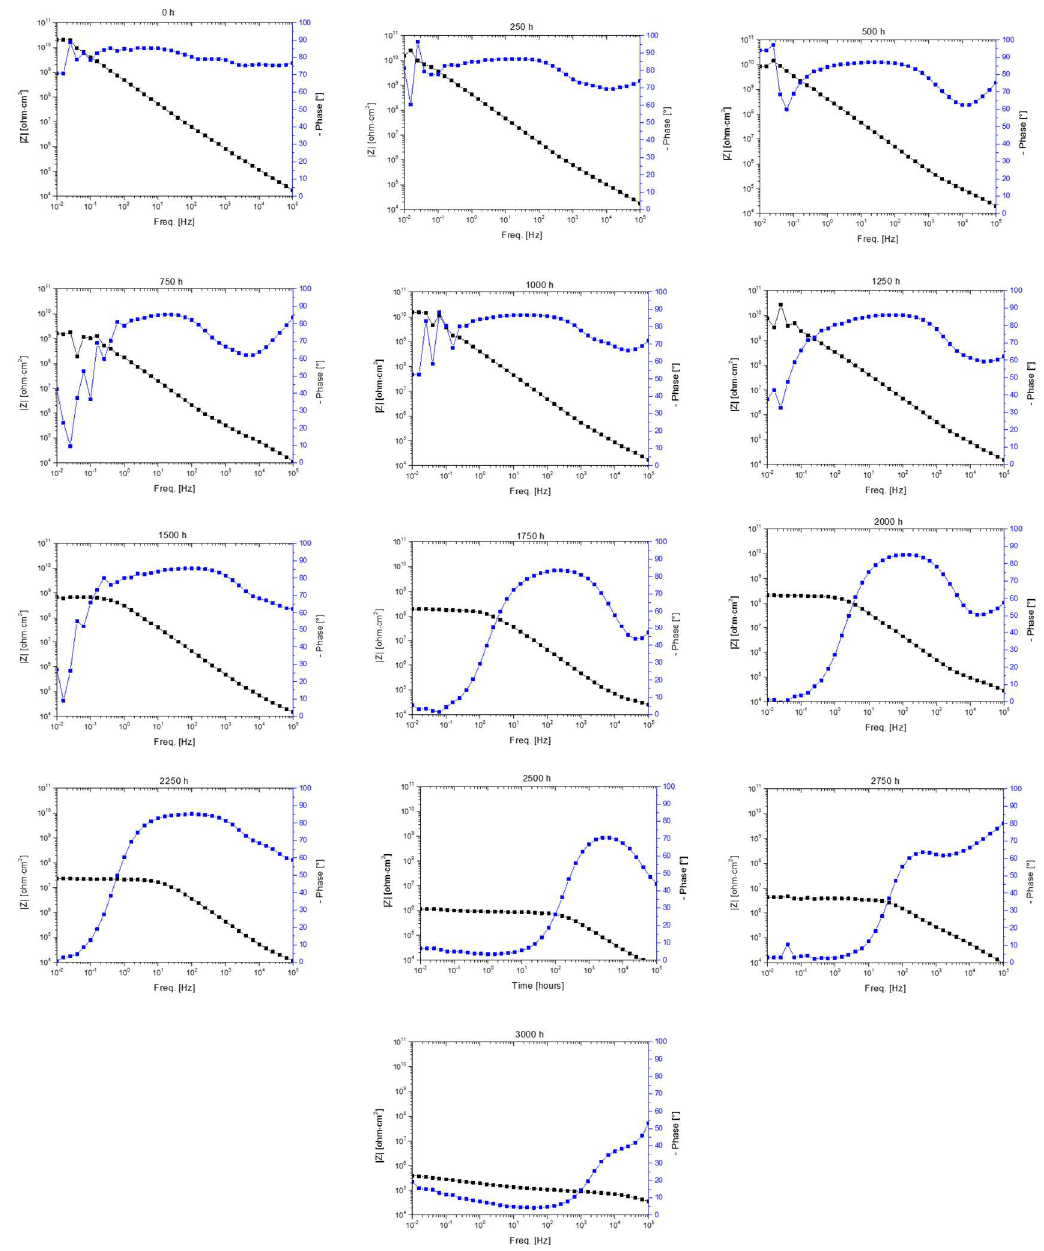
Figure A1. EIS spectra of a painted steel sample at different aging times during the prohesion test.